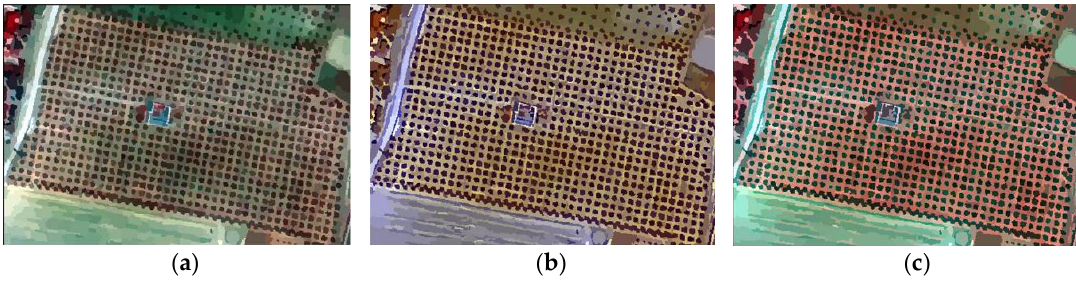
Figure 2. Multiresolution segmentation of pansharpened QuickBird (QB) imagery in field A. Pansharpen weight (B-G-R-NIR): ( a ) 1-1-1-1; ( b ) 1-1-5-5; and ( c ) 1-1-1-10. Pansharpen weight (B-G-R-NIR): ( a ) 1-1-1-1; ( b ) 1-1-5-5; and ( c )